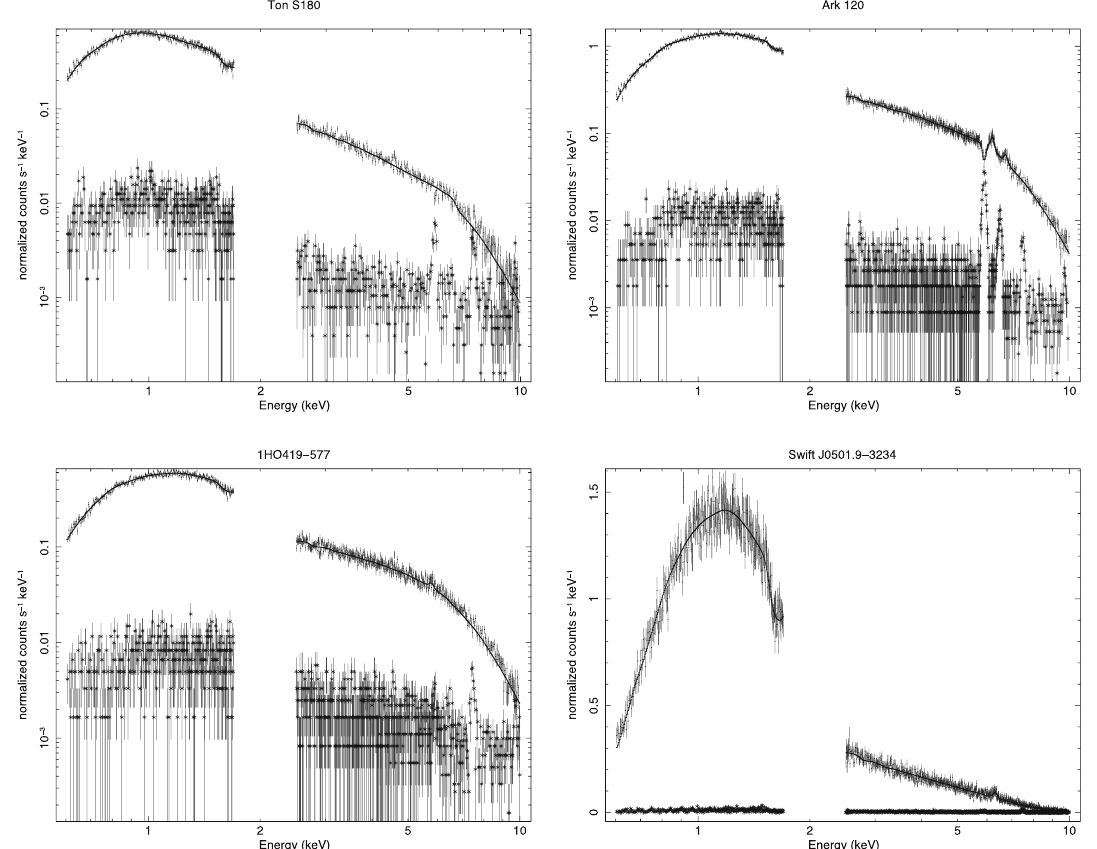
Fig. 6 Source spectra, background spectra, and folded models of the Suzakudata of Ton S180, Ark 120, 1H0419–577, and Swift J0501.9–3239